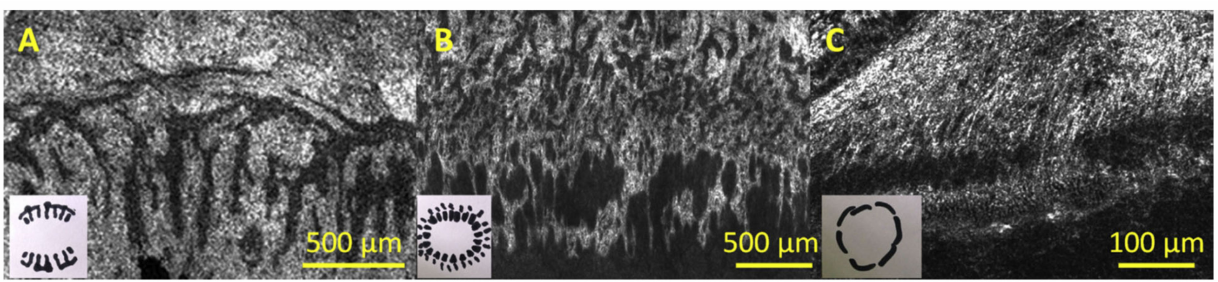
Figure 5. Interspecies variation in limbal morphology: human, pig and mouse. En face FFOCM (full-field optical coherence microscopy) pictures of ( A ) human, ( B ) pig and ( C ) mouse limbus, with inset diagrams of geometry of crypt formation about 360 ◦ of the eye. FFOCM pictures are oriented with the sclera on top and the cornea on the right. Photos have been measured to represent an identical area of every cornea (though differently sized due to different eye sizes)